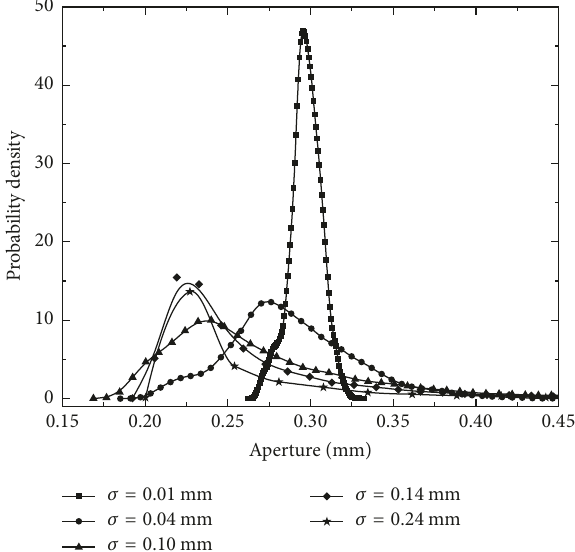
Figure 13: Probability density as a function of aperture.